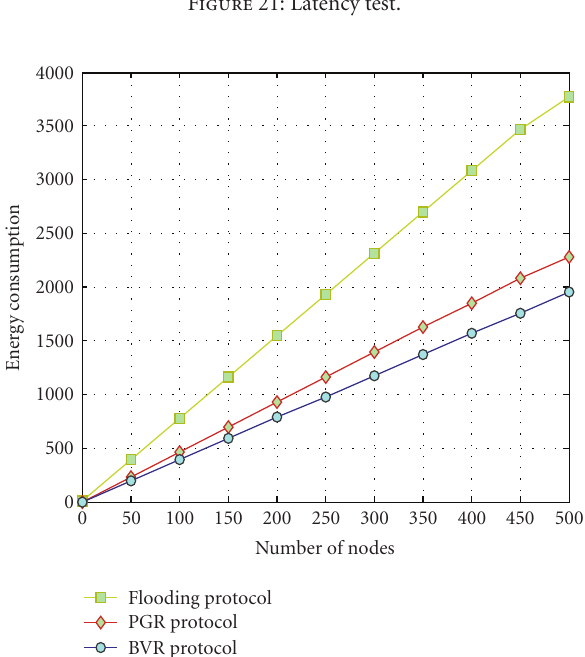
Figure 20: The throughput test.